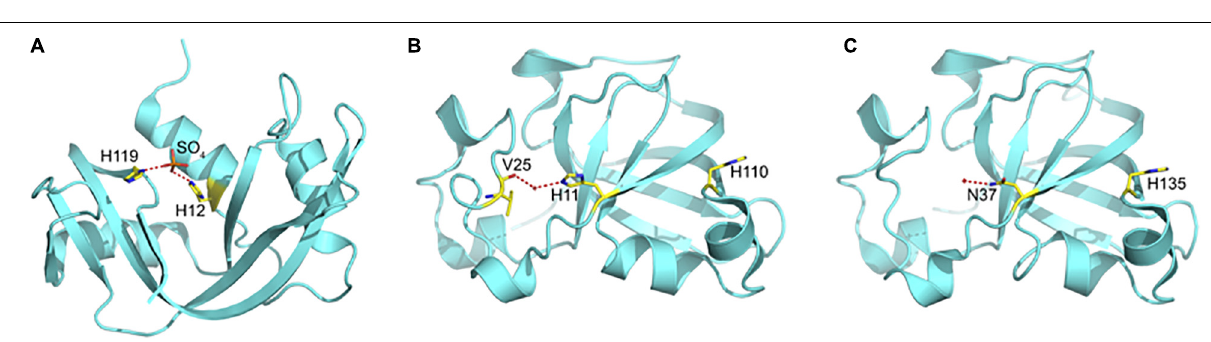
FIGURE 3 | The Catalytic Site in (A) Ribonusease A, (B) CARWIN, and (C) SUGARWIN2. In RNaseA, the catalytic histidines are orientated toward one another and bound to a sulfate ion which mimics the substrate where hydrolytic attack occurs. In CARWIN, although present, the histidines are orientated away from one another and the side chain of His11 is connected to the insertion within the variable loop by water mediated hydrogen bonds. In order to cleave RNA, it is expected that RNase active enzymes (including SUGARWIN1) must undergo a large conformational change to bring the two histidines into the correct orientation for catalysis.